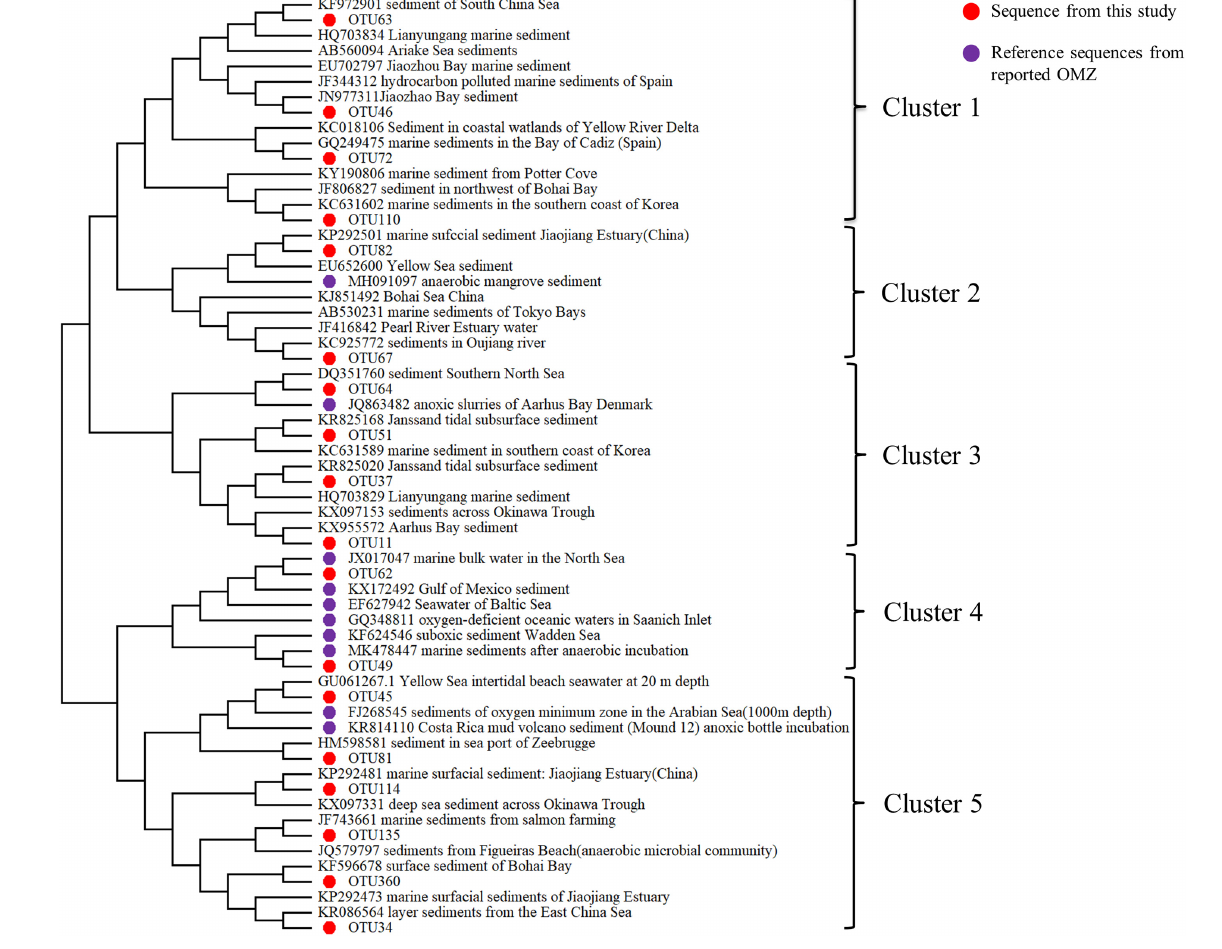
Frontiers in Marine Science |